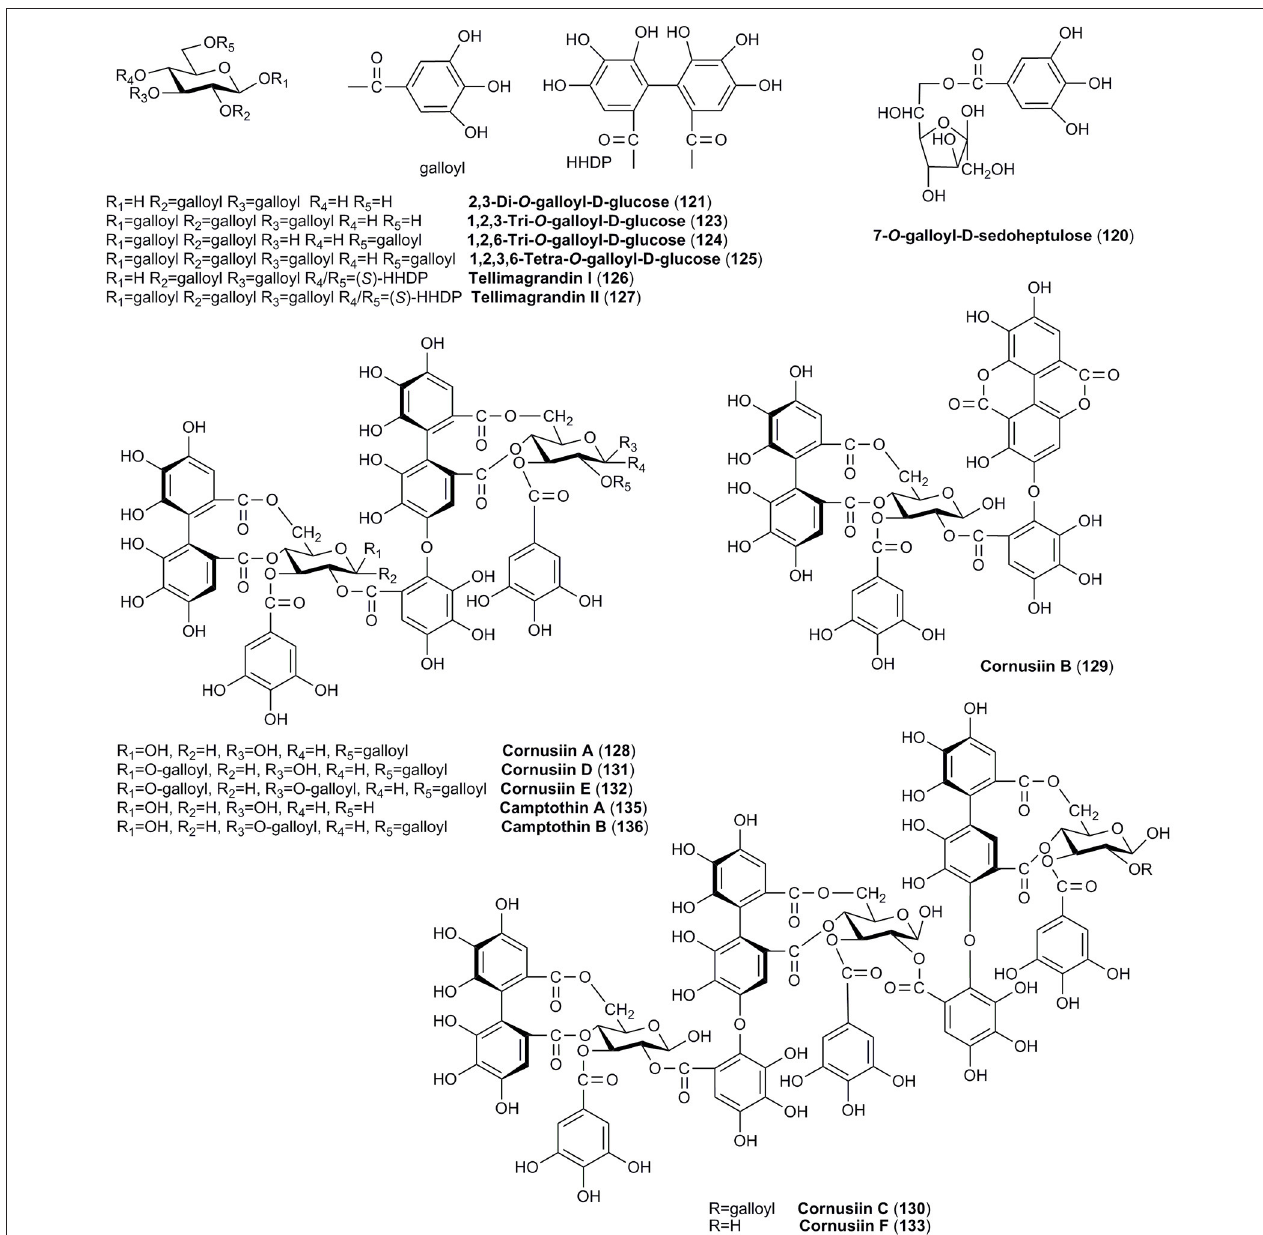
FIGURE 5 | The chemical structures of tannins identified in fruits of C. officinalis